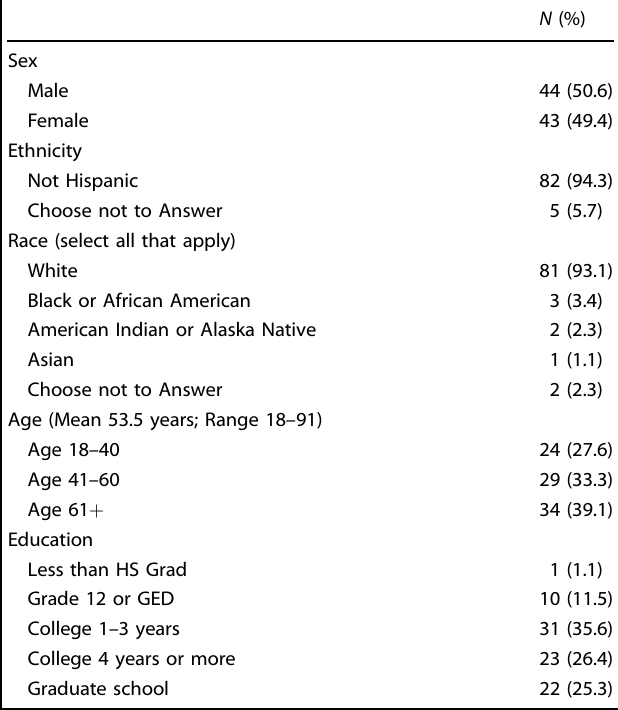
Table 1. Characteristics of 87 patients who participated in focus groups examining attitudes about the use of AI in